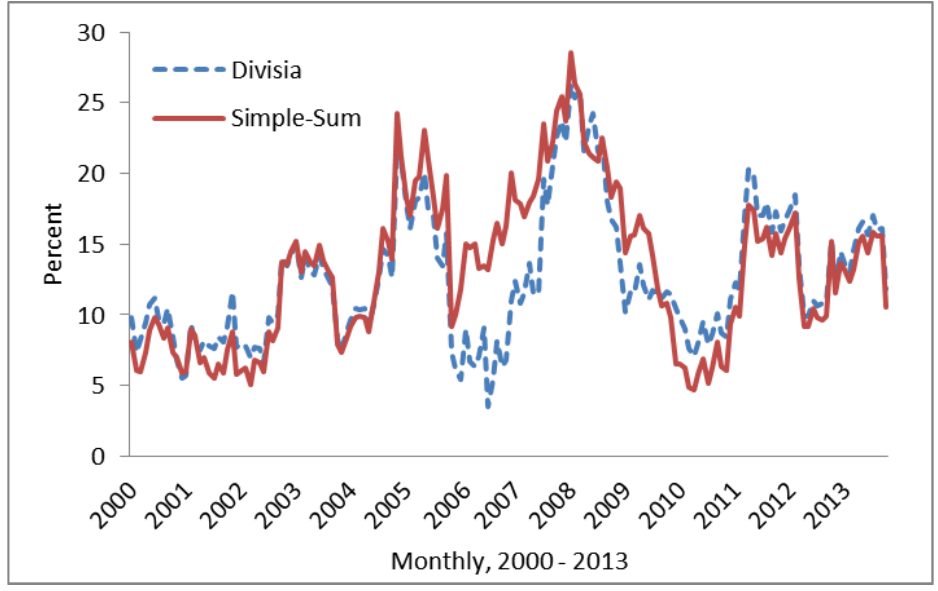
Figure 2. Year-Over-Year Growth Rates of the Divisia and Simple-Sum Monetary Aggregates, M2 (Annual Percentage